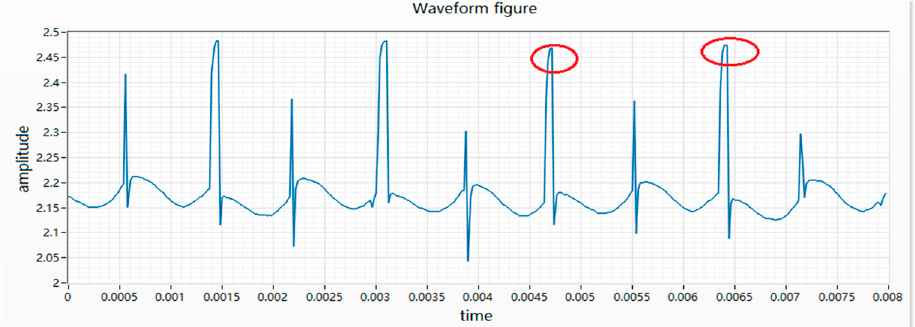
Figure 6. Waveform of a defective brush.